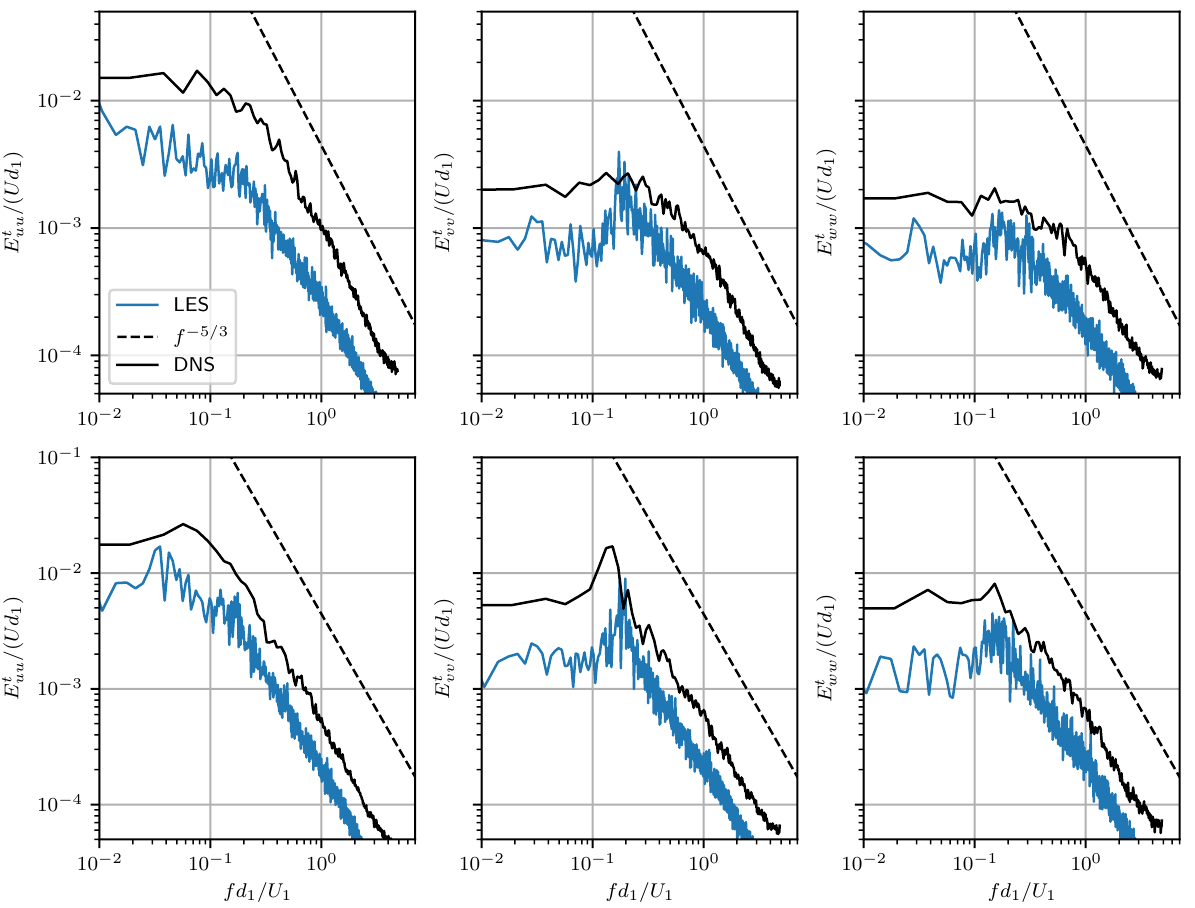
Figure 8. Temporal energy spectra of the three components of velocity at two selected [ x (cid:48) , y (cid:48) ] positions: [ 1.24,1 ] ( top ); [ 3.24,1.1 ] ( bottom ).